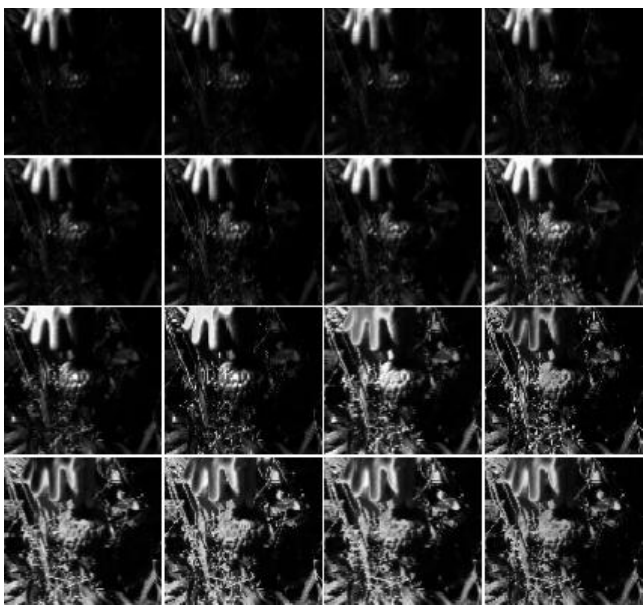
Figure 5. Edge features in 16